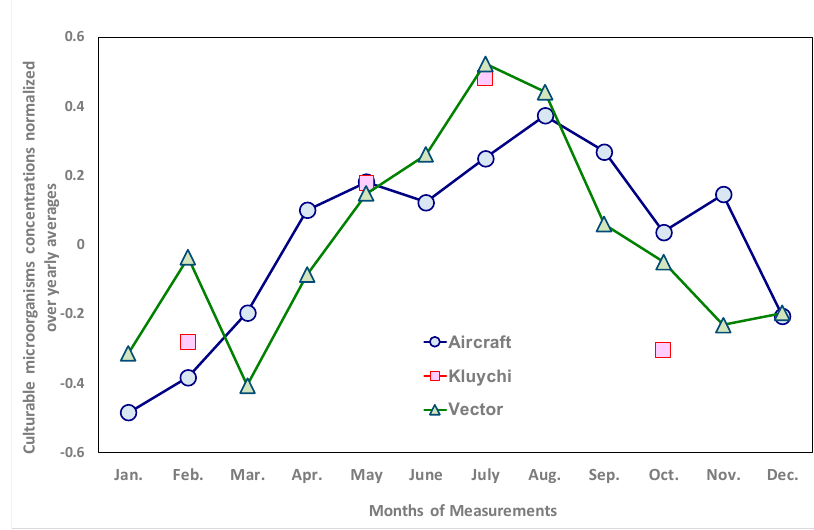
Figure 6. Intra-annual variability of concentrations of culturable microorganisms in the atmospheric aerosol of the south of Western Siberia. The average values for a given month for the entire observation period and the standard deviations from the average are given.